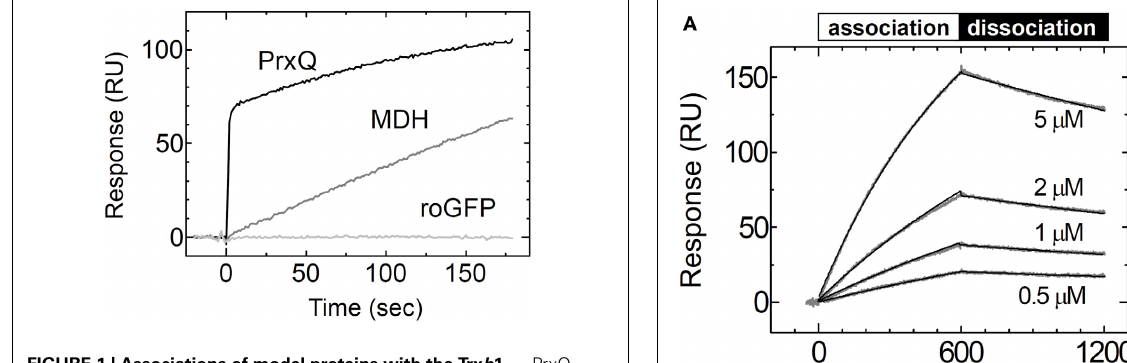
FIGURE 1 | Associations of model proteins with the Trx h 1 CS . PrxQ, MDH, or roGFP at 5 μ M were injected onto the Trx h 1 CS immobilized on a CM5 sensor chip. Experiments were performed at a flow rate of 30 μ l/min for PrxQ and 10 μ l/min for MDH and roGFP.